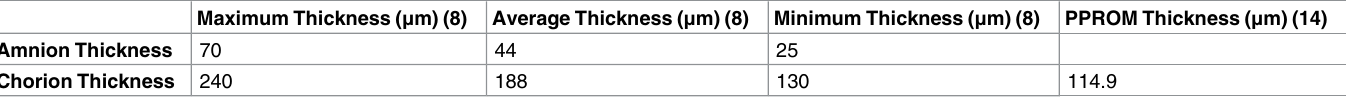
Table 2. Previously reported ranges of thickness for the chorion and amnion from [10], as well as for the chorion during PPROM pressure from [16].